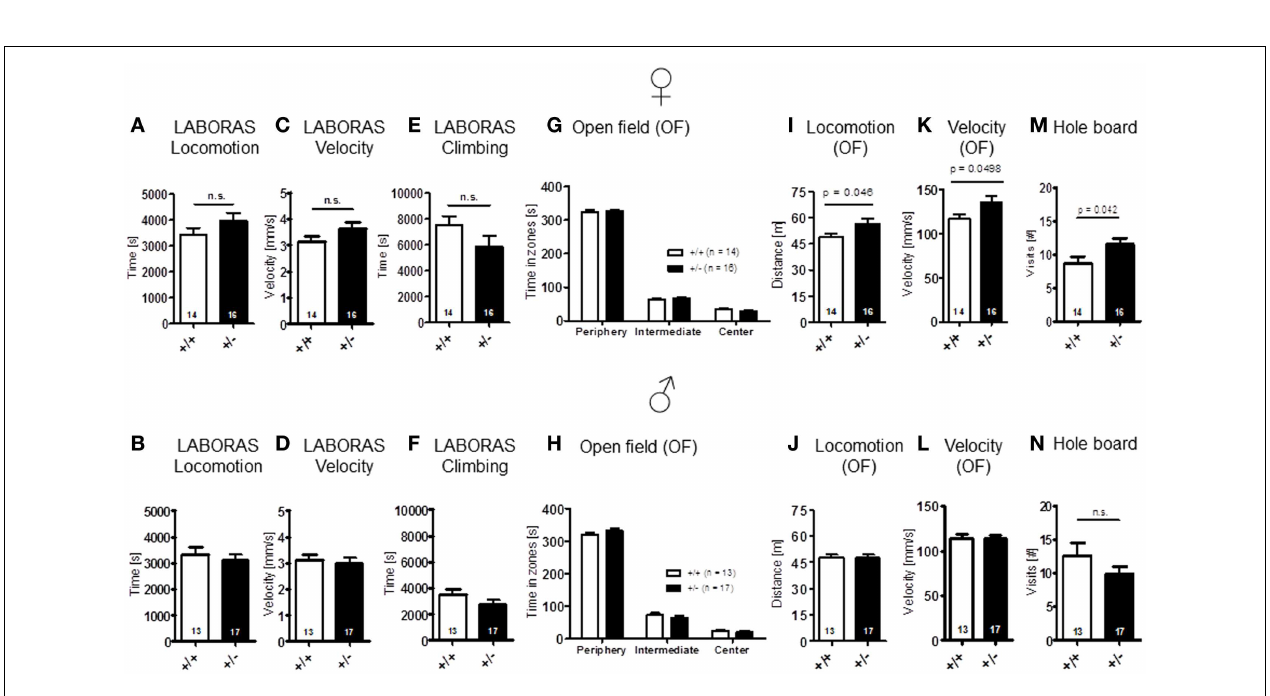
readouts; (G–L) open field; and (M,N) hole board. Female Ambra1 + / − appear slightly more active. Mean ± SEM presented; respective sample sizes are indicated in the